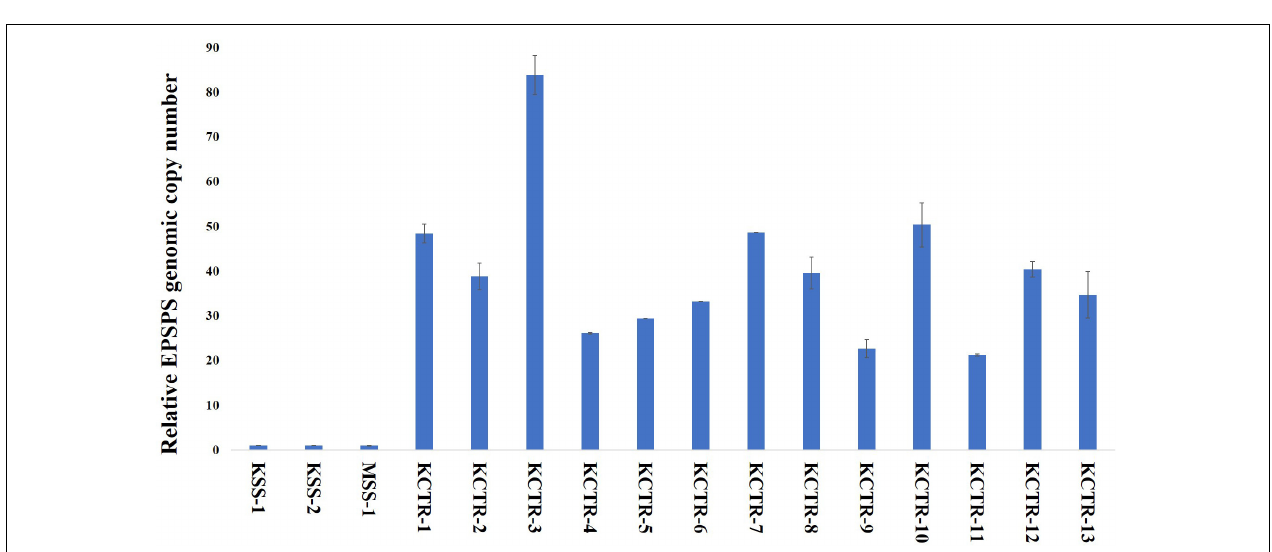
FIGURE 3 | Nucleotide sequence alignment of psbA gene fragments from atrazine-susceptible (MSS and KSS) and -resistant (KCTR) Palmer amaranth individuals. No nucleotide polymorphisms were observed among KCTR, KSS, and MSS Palmer amaranth individuals.